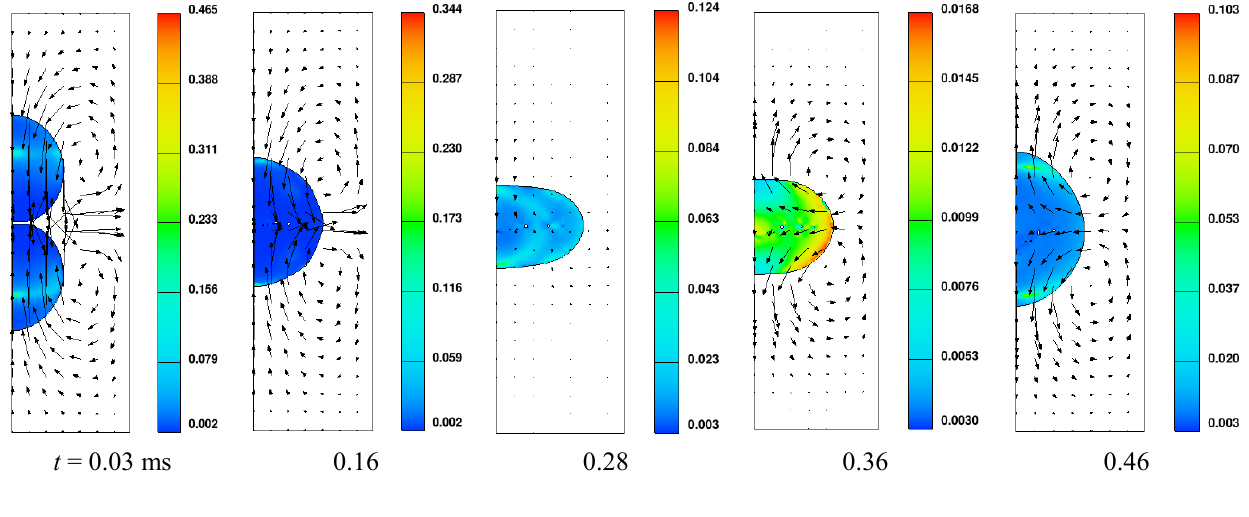
t = 0.03 ms 0.16 0.28 0.36